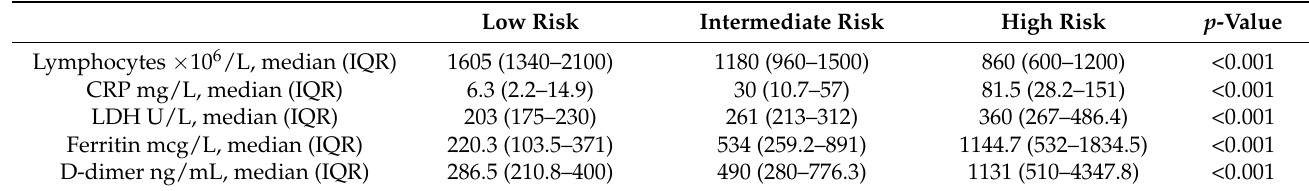
Table 4. Lab tests upon admission for the three categories.